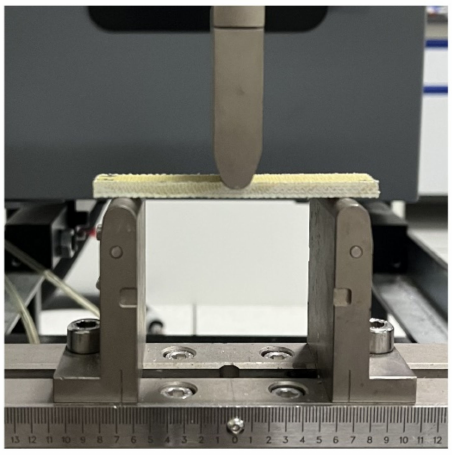
Figure 4. Schematic diagram of three point bending tests.